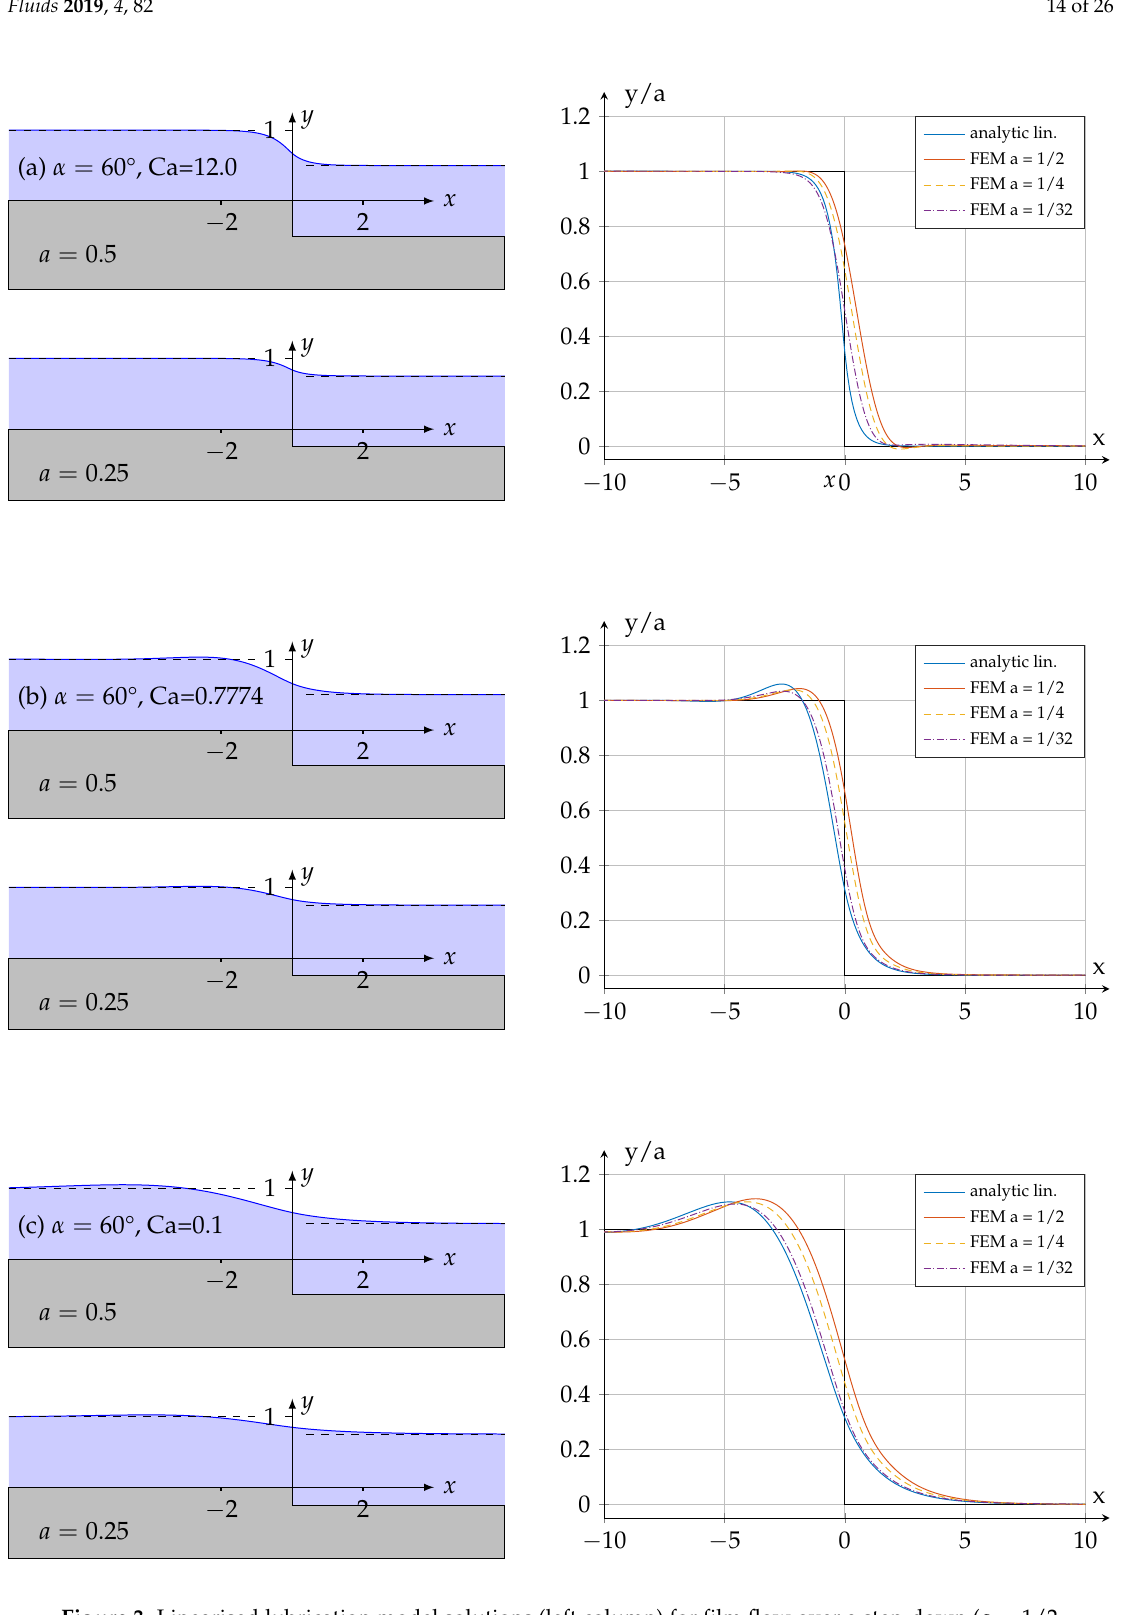
Figure 3. Linearised lubrication model solutions (left column) for film flow over a step-down ( a = 1/2, 1/4 and 1/32 for different values of Ca (12.0 (top), 0.7774 (middle), 0.1 (bottom)) and α = 60°) showing the predicted free surface disturbance (blue curve), compared with FE solutions of the first integral equations (right column; using a different scaling for clarity): ( a ) monotonic transition; ( b , c ) damped spatial oscillations upstream. The flow is from left to right, the dashed lines in the left-hand column indicating the unperturbed film thickness on the upstream and downstream sides of the